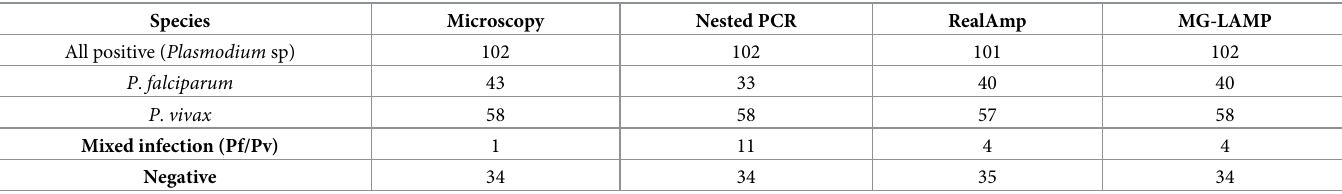
Table 1. Summary of results performed by each methodology.